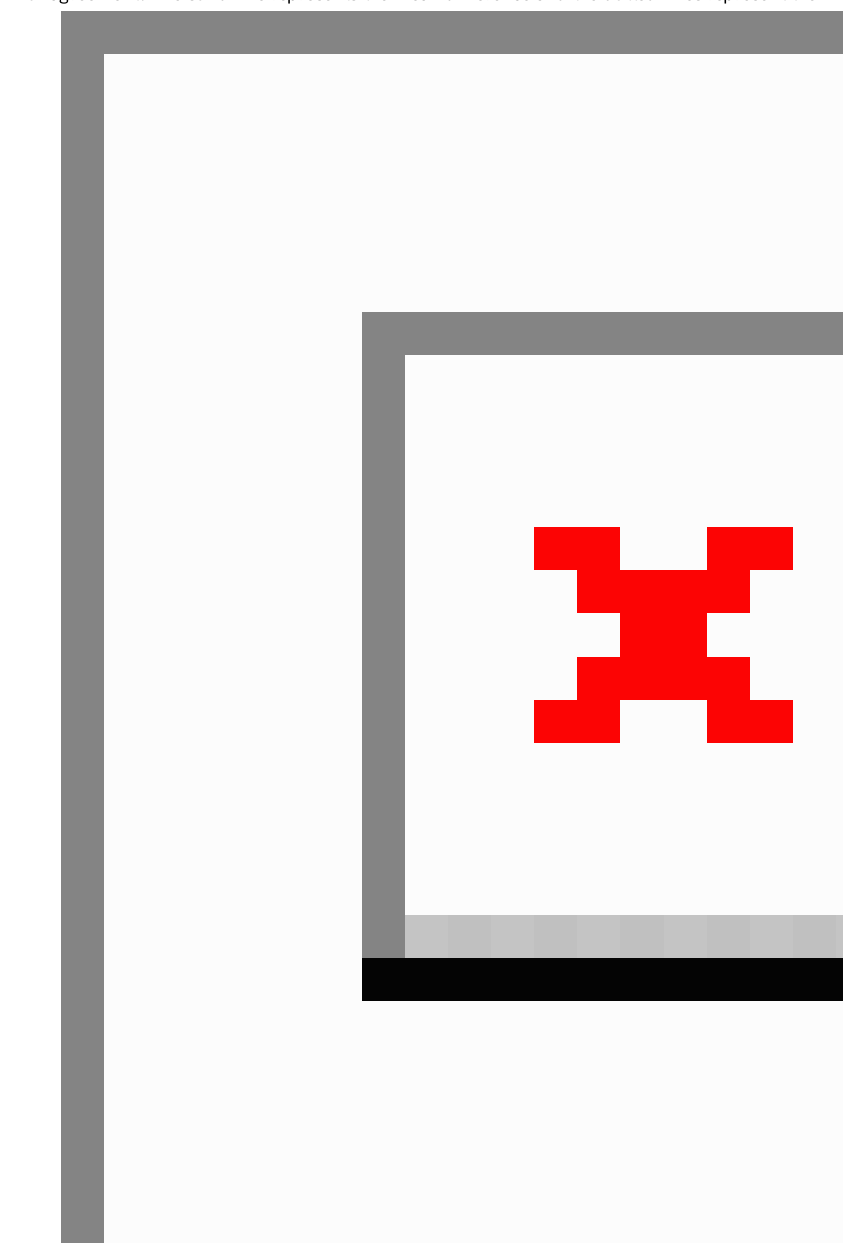
Figure 3. Reproducibility study Bland-Altman plots for (a) energy, (b) total fat, (c) protein, and (d) carbohydrate with the mean difference and limits of agreement. The solid line represents the mean difference and the dotted lines represent the limits of